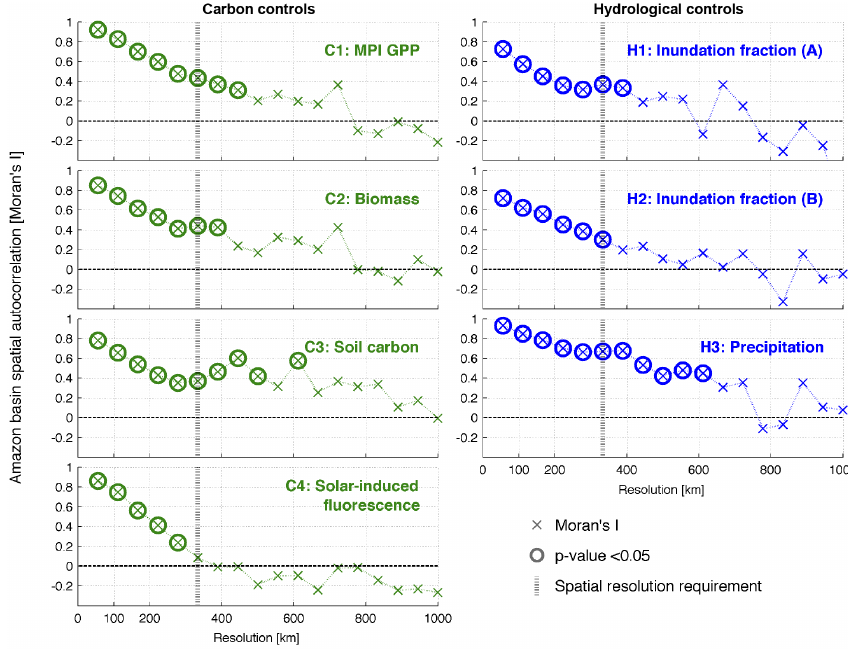
Figure 3. Spatial autocorrelation (Moran’s I) for potential carbon controls (left column) and hydrological controls (right column) on wetland CH 4 emissions. The spatial variability of carbon controls are derived from satellite observations (biomass in Saatchi et al., 2011; solar- induced fluorescence in Joiner et al., 2013), the Harmonized World Soil Database (soil carbon; Hiederer and Köchy, 2011) and FLUXNET- derived GPP (Jung et al., 2009). The spatial variability estimates for hydrological controls are based on satellite measurements of inundation (A: Prigent et al., 2012; B: Schroeder et al., 2015) and precipitation (the NASA Tropical Rainfall Measuring Mission). Significant Moran’s I values (where the Moran’s I p value < 0.05) are highlighted as circles. We set a ∼ 333km spatial resolution requirement for monthly CH 4 flux retrievals, based on the maximum correlation lengths of potential carbon and hydrological controls on wetland CH 4 emissions. The details of the Moran’s I analysis are fully described in Appendix